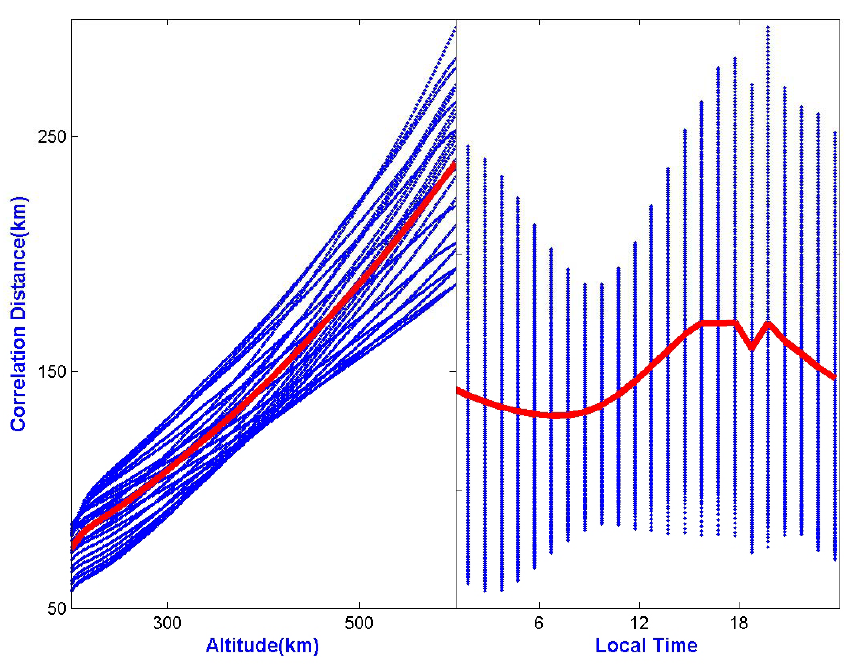
Figure 5. Altitude and Local time variations of vertical correlation distance. The solid lines in the left Fig. 5. Altitude and local time variations of the vertical correlation distance. The solid lines in the left panel are mean values of different panel are mean values of different local times and in the right panel are mean values of different local times and in the right panel are mean values of different altitudes.